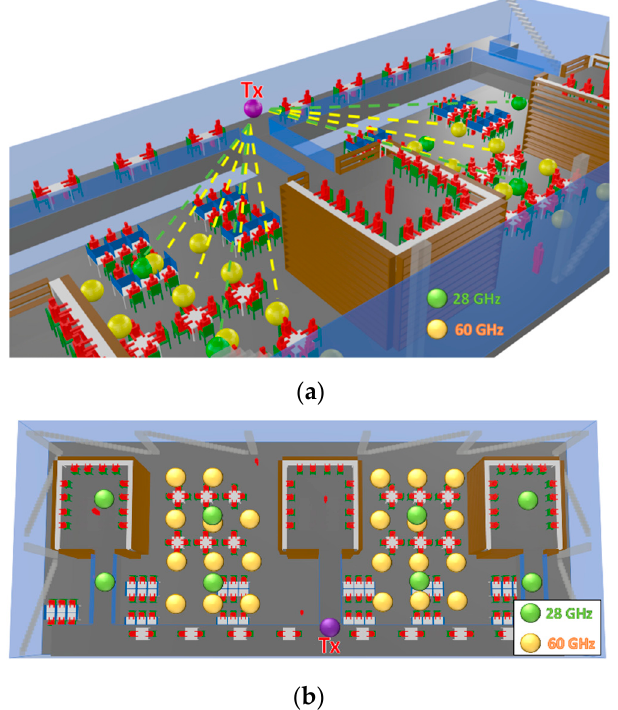
Figure 9. Transmitter antenna beamforming and receiver measurement points for the 28 and 60 GHz operating frequencies when the transmitter is placed on the second floor: ( a ) 3D view and ( b ) 2D view.